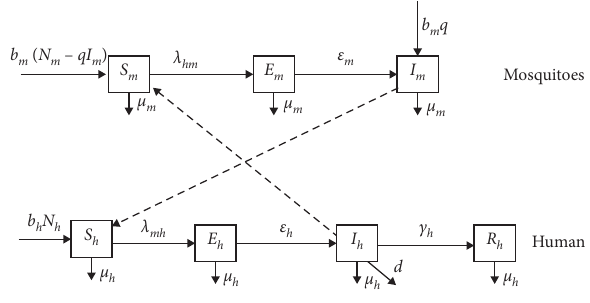
Figure 1: Transmission diagram for RVF. Table 1: Description of